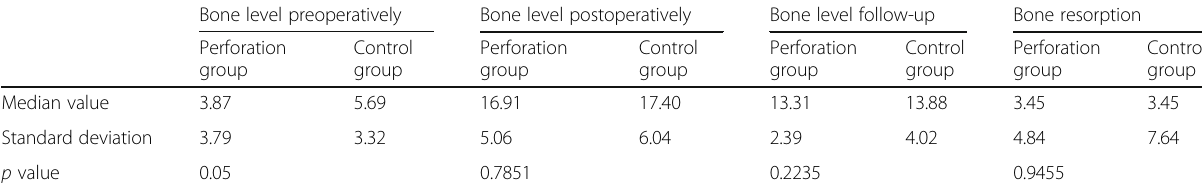
Table 3 Data summary of bone level development